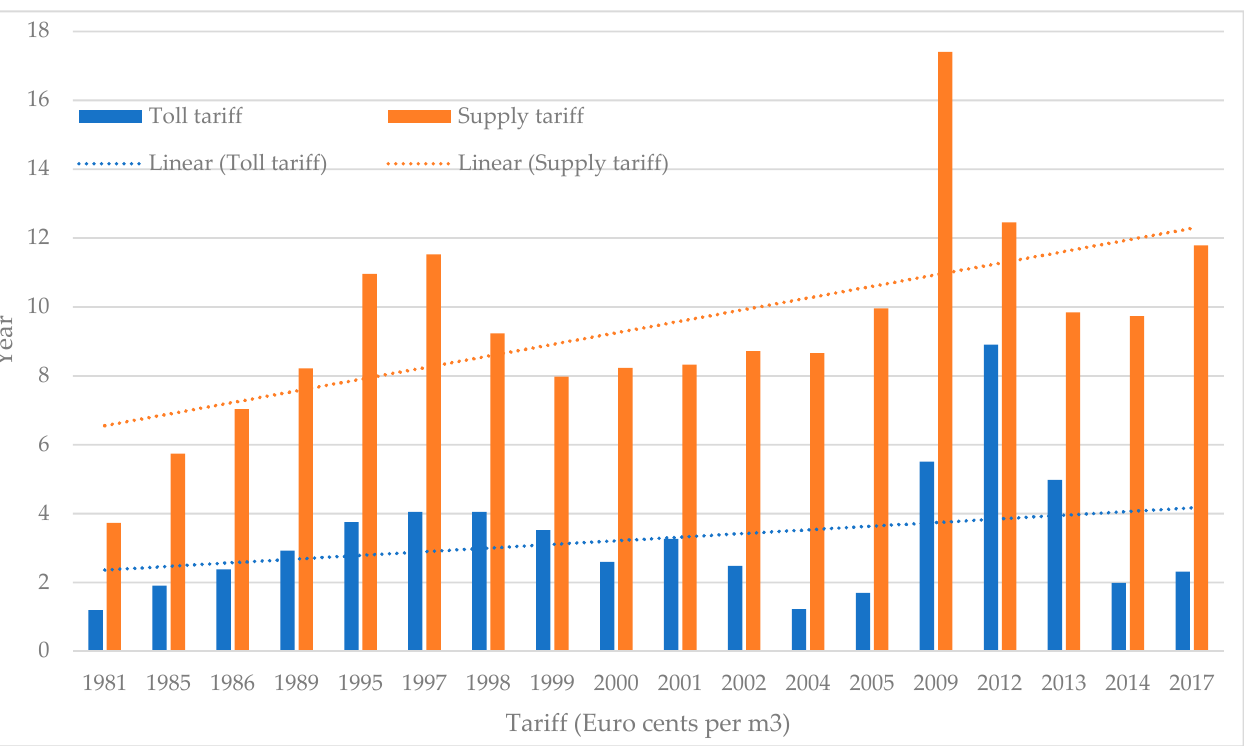
Figure 4. Evolution of the tariff and the toll tariff (both for irrigation) of the Tagus ‐ Segura aqueduct in euro cents per cubic metre. Source: [32,45].